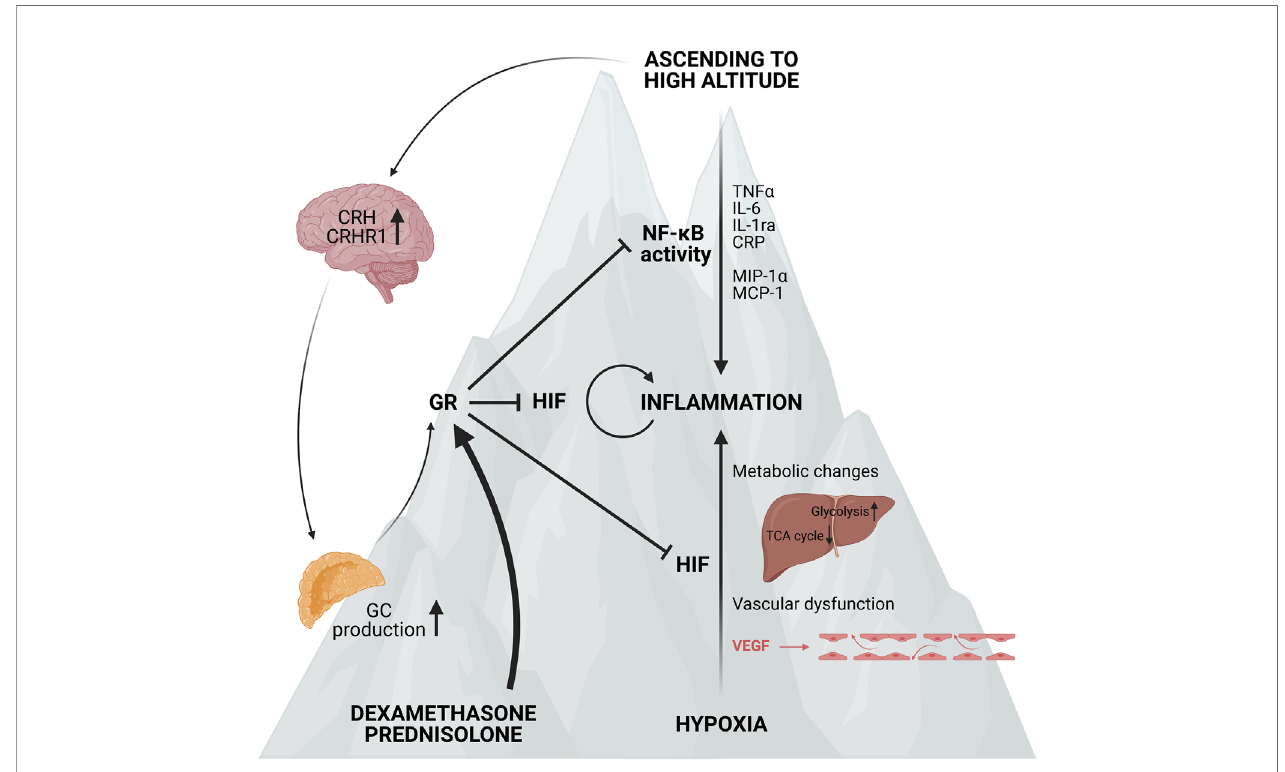
FIGURE 7 | Acute mountain sickness (AMS) and the prophylactic effect of synthetic GCs. Ascending to high altitude can lead to the development of AMS. This is characterized by elevated NF- k B expression and higher levels of po-in fl ammatory markers such as TNF a , IL-6, IL-1ra, CRP and chemokines like MCP-1 and MIP-1 a . Next to the in fl ammatory response, the expression of CRH and its receptor CRHR1 in the hypothalamus is also elevated, leading to increased GC production by the adrenal glands and stimulation of the GR. When ascending to high altitude, the hypoxic response is also characterized by metabolic changes and vascular dysfunction induced by the vascular endothelial growth factor (VEGF) contributing to the in fl ammatory response. When pre-treated with synthetic GCs such as dexamethasone and prednisolone, the GR is stimulated and the NF- k B and HIF mediated responses are inhibited and the symptoms of AMS are reduced. Figures created with